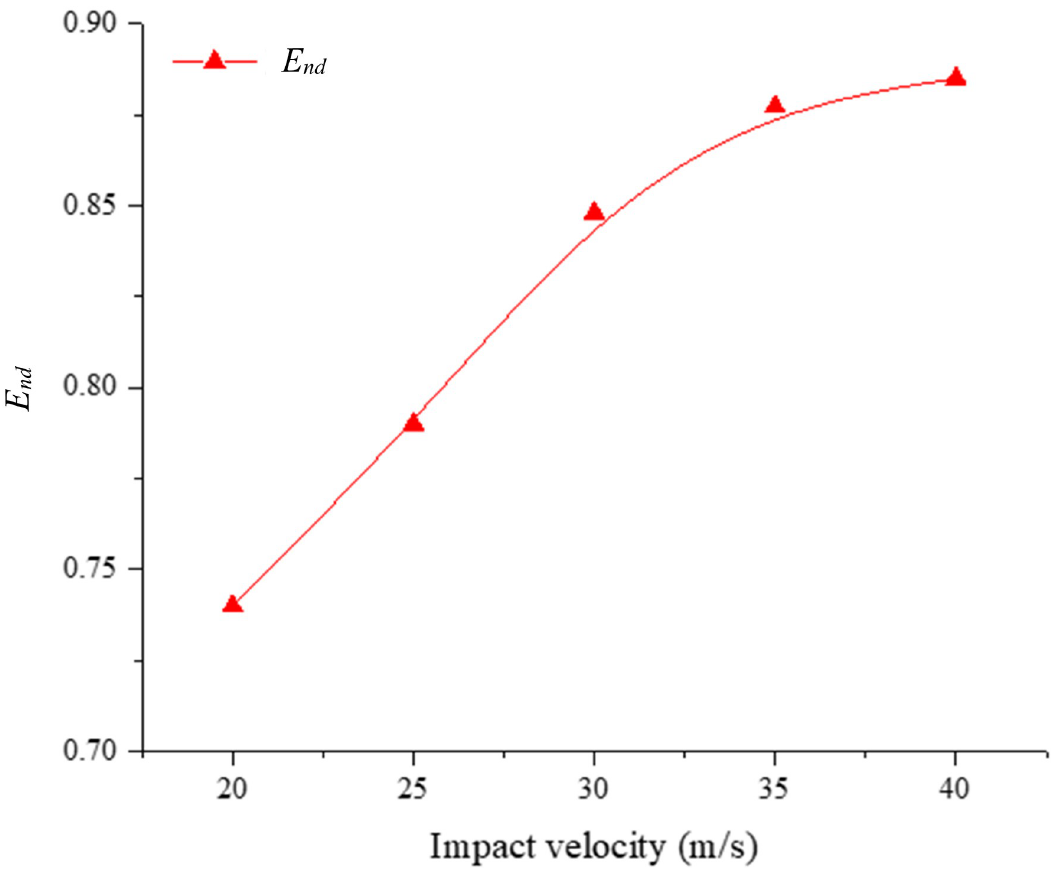
Fig 14. Variation in the energy dissipation ( E